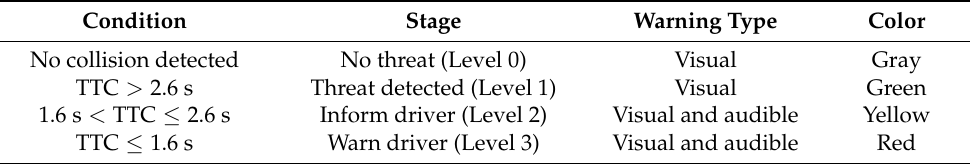
Figure 5. Illustration of collision prediction based on the circle model [23]. The detection of a possible collision leads to the generation of a collision warning to the host vehicle. Based on the time-to-collision (TTC) estimate, four different collision warning messages are provided. Following the collision warning stages discussed in [69], the warning messages provided by the proposed system include “no threat” for no possible collision, “threat detected” for TTC > 2.6 s, “inform driver” for 1.6 s < TTC ≤ 2.6 s, and “warn driver” for TTC ≤ 1.6 s. The description for each warning message is described in Table 5. The conditions for the collision warning messages defined here are similar to those of Daimler PRE-SAFE [70] and Mobileye FCW [71]. The PRE-SAFE and Mobileye systems warn the driver approximately 2.6 s and 2.7 s before the expected collision, respectively. In the case of the PRE-SAFE system, an additional warning is provided at approximately 1.6 s before the expected collision. Table 5. Vehicle collision warning conditions